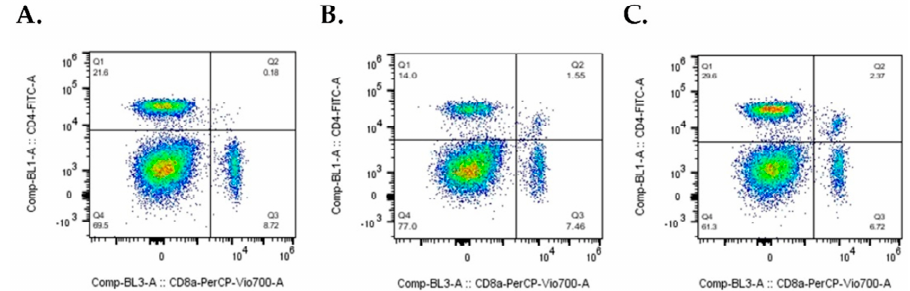
Figure 4. Changes in T cell populations. Flow cytometer results from individual samples are presented; dot plots were generated from a mouse injected with PBS ( A ), A549 cells ( B ), and A549 NED cells ( C ). Q1 contains CD4-positive cells, Q2 contains CD4/CD8 double-positive cells, Q3 encompasses CD8 positive cells, and Q4 includes cells that are negative for both CD4 and CD8.